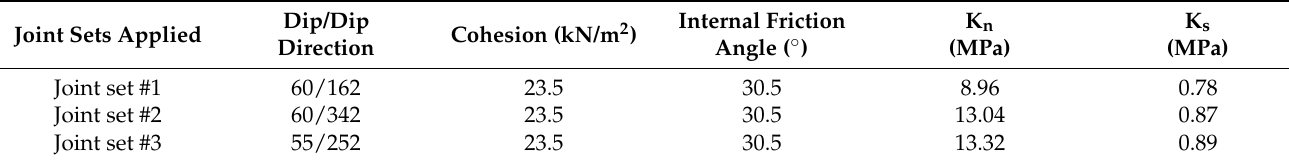
Table 1. Soil and rock parameters used for this study [26,27].